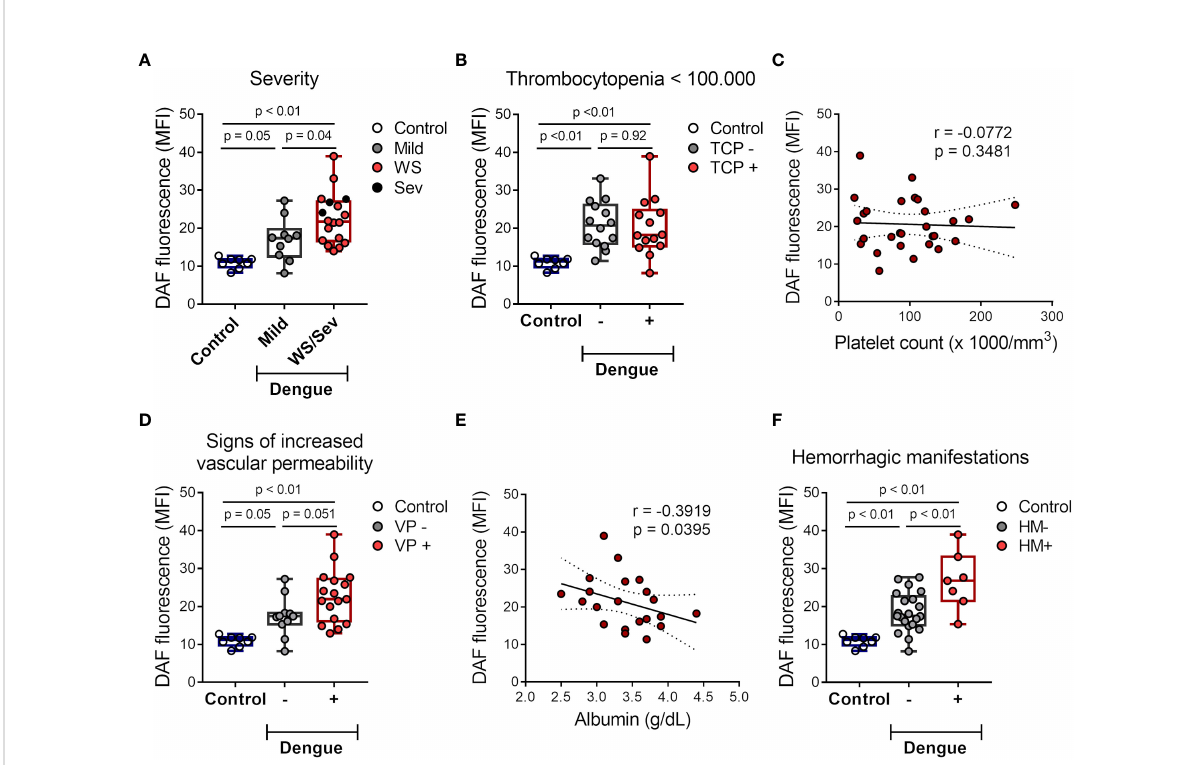
FIGURE 2 NO production by platelets from dengue-infected patients associates with disease severity. (A) The mean of fl uorescence intensity (MFI) of DAF- FM diacetate fl uorescent probe indicating NO synthesis in platelets from healthy volunteers (control) (n = 8) and patients with mild dengue (n = 10) or that evolved with warning signs (WS) or severe dengue syndrome (n = 18). (B) NO synthesis in platelets from control (n = 8) and dengue patients that were positive or negative for thrombocytopenia (TCP) (14 vs 14 patients, respectively). (C) NO synthesis in platelets was plotted against the lower platelet count in each patient, linear regression and 95 % con fi dence interval was traced according to the distribution of the dots. (D – F) NO synthesis in platelets from control (n = 8) and dengue patients that were positive or negative for clinical signs of increased vascular permeability (VP) (11 vs 17 patients, respectively) (D) or hemorrhagic manifestations (HM) (21 vs 7 patients, respectively) (F) . (E) NO synthesis in platelets was plotted against the lower plasma albumin levels in each patient, linear regression and 95 % con fi dence interval was traced according to the distribution of the dots. Each dot represents one patient or healthy volunteer. The horizontal lines in the box plots represent the median, the box edges represent the interquartile ranges, and the whiskers indicate the minimal and maximal values in each